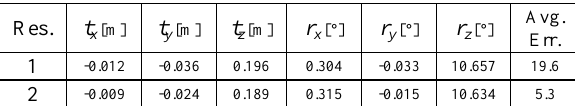
Table 5: Transformation parameters computed with Final Surface